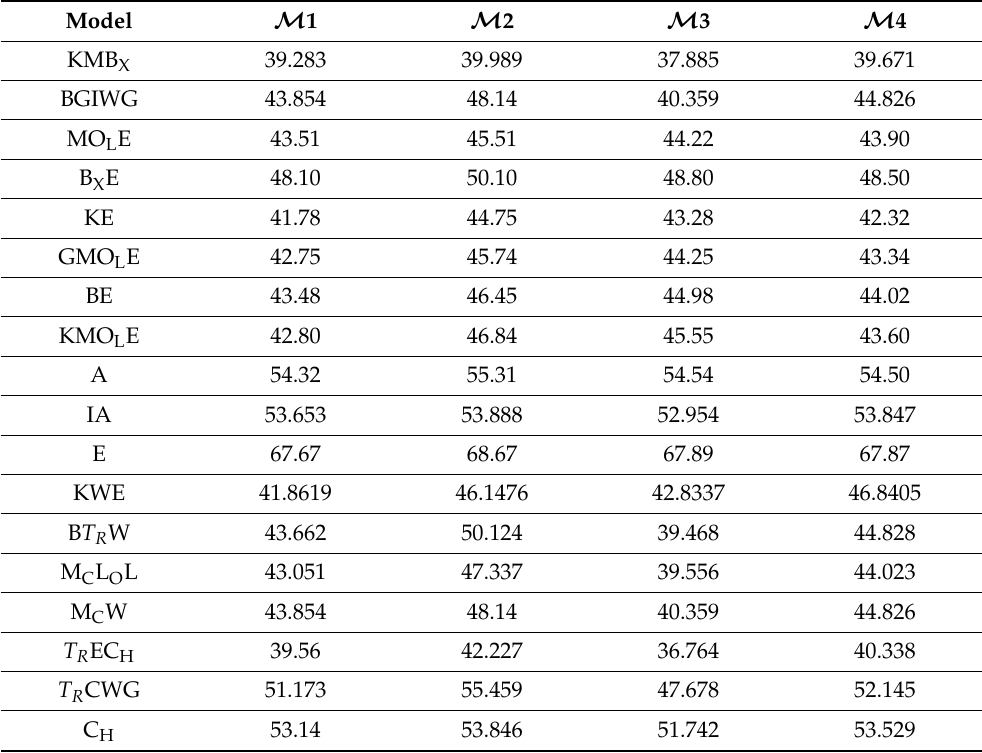
Table 10. Numerical values of M 1, M 2, M 3, and M 4 for the second data